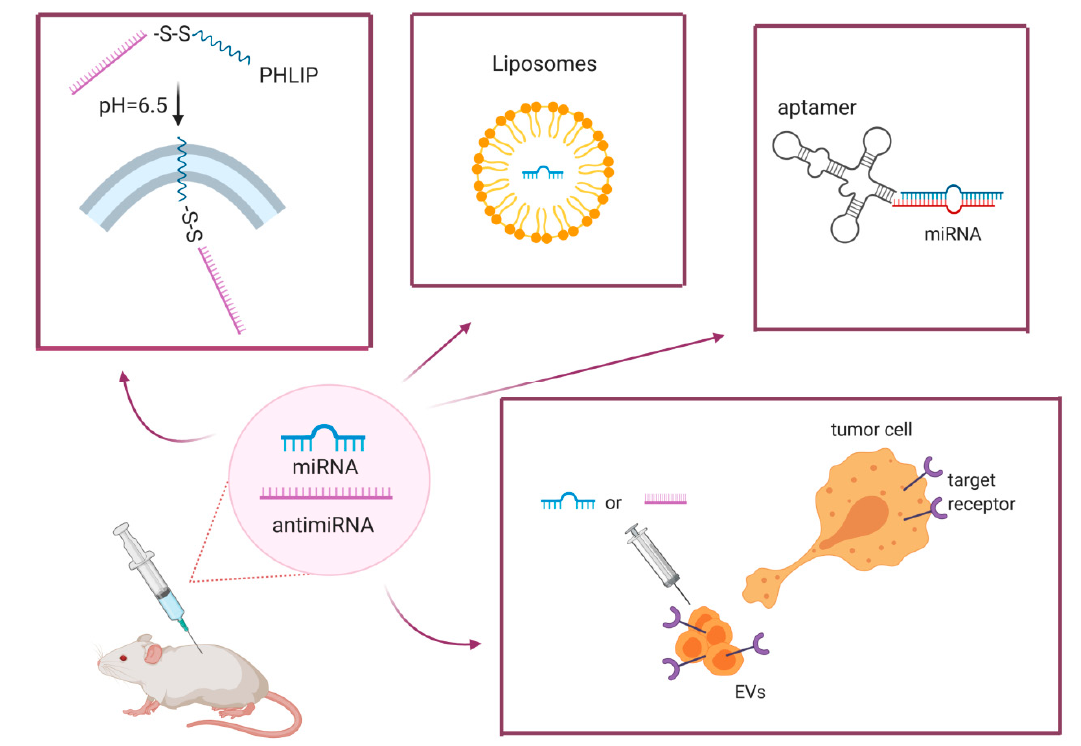
/ anti-miRNA delivery